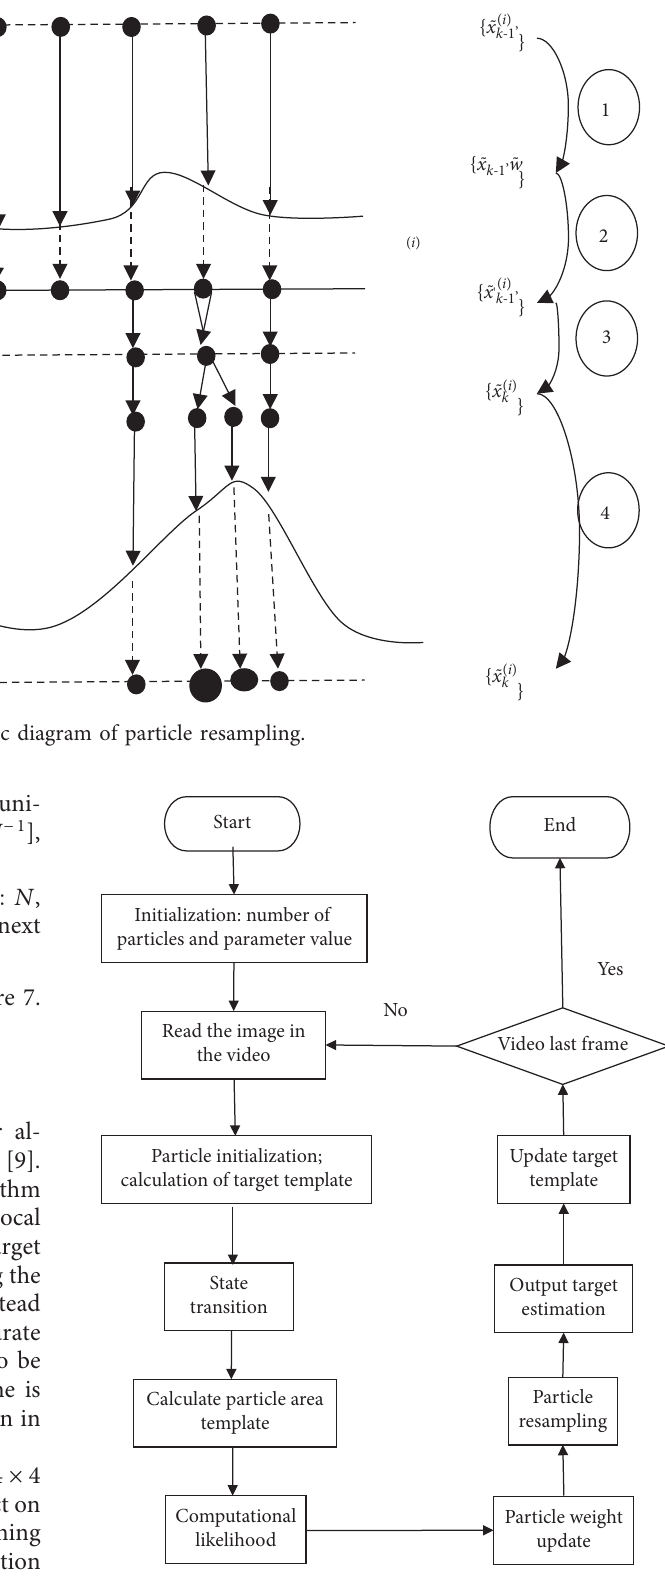
Figure 7: Particle filter target tracking